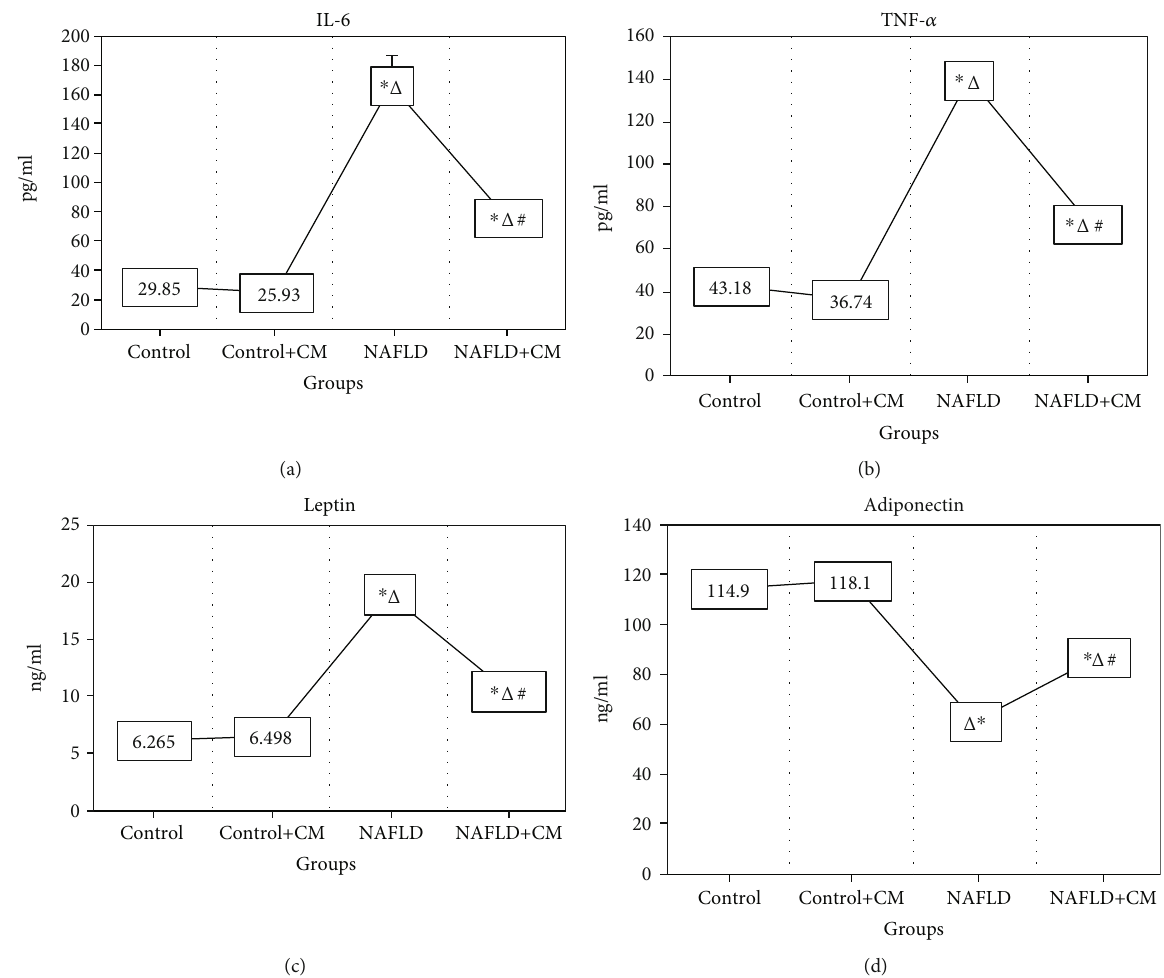
Figure 5: The serum levels of IL-6 (a), TNF- α (b), leptin (c), and adiponectin (d) in the control, camel milk (CM) treated control (control +CM), nonalcoholic fatty liver disease (NAFLD), and CM-treated NAFLD (NAFLD+CM) animals. ∗ p < 0 : 05 versus the control group, Δ p < 0 : 05 versus the control+CM group, and # p < 0 : 05 versus the NAFLD